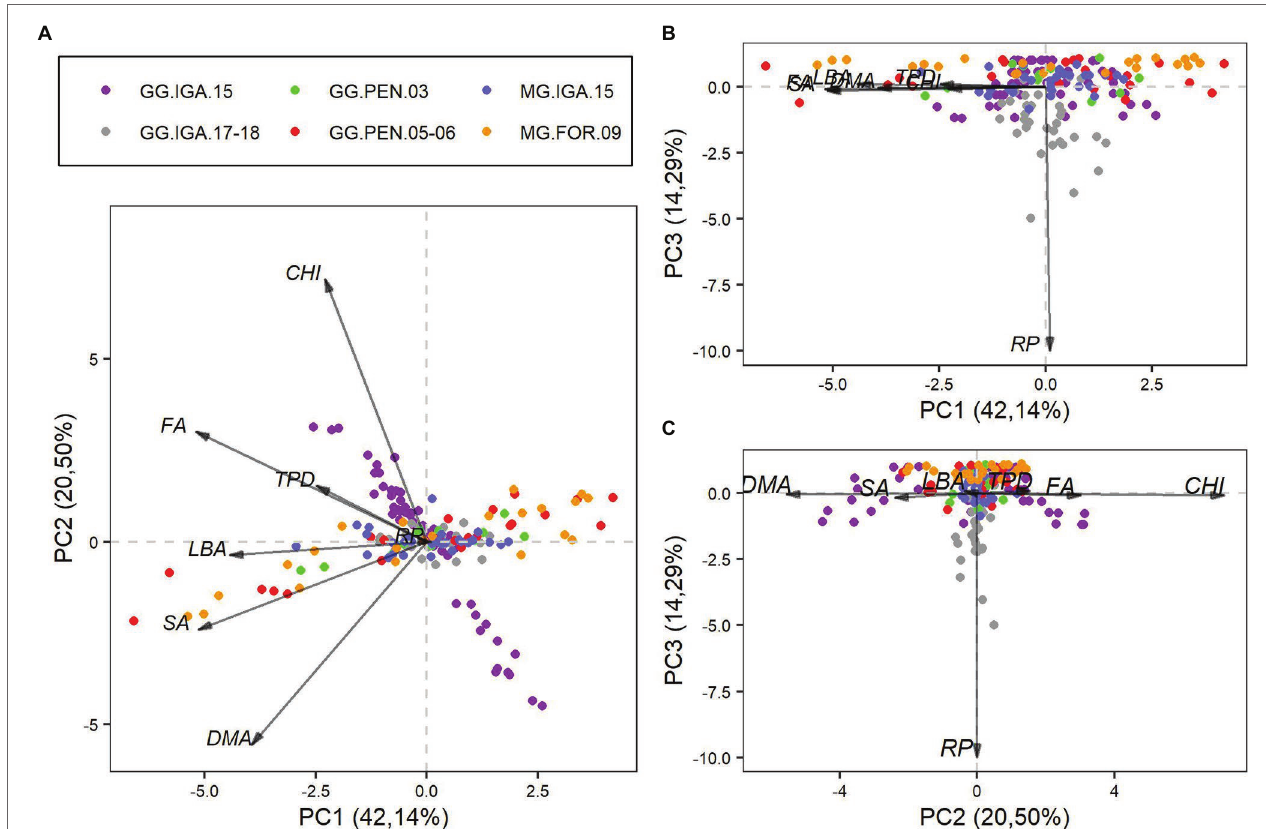
FIGURE 4 | Biplot representation of the first three main components obtained from the agrometeorological variables, with observations from the six types of trials with cultivars of the species Megathyrsus maximus . (A) Bidirectional relationship of principal component 1 with principal component 2. (B) Bidirectional relationship of principal component 1 with principal component 3. (C) Bidirectional relationship of principal component 2 with principal component 3. CHI, Canopy height increment; DMA, Dead material accumulation; FA, Forage accumulation; LBA, Leaf blade accumulation; SA, Stem accumulation; and TPD, Tiller population